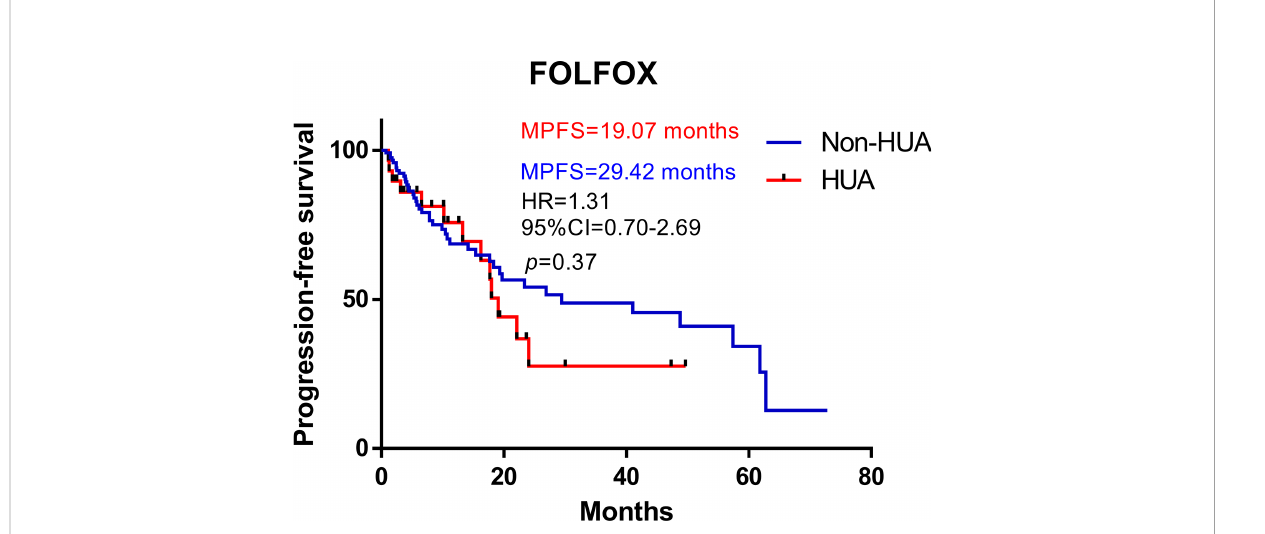
FIGURE 1 Kaplan-Meier plots comparing the PFS of the different baseline SUA level CRC patients treated with FOLFOX. HUA, high uric acid, Non-HUA, non-high uric acid, MPFS, median PFS.